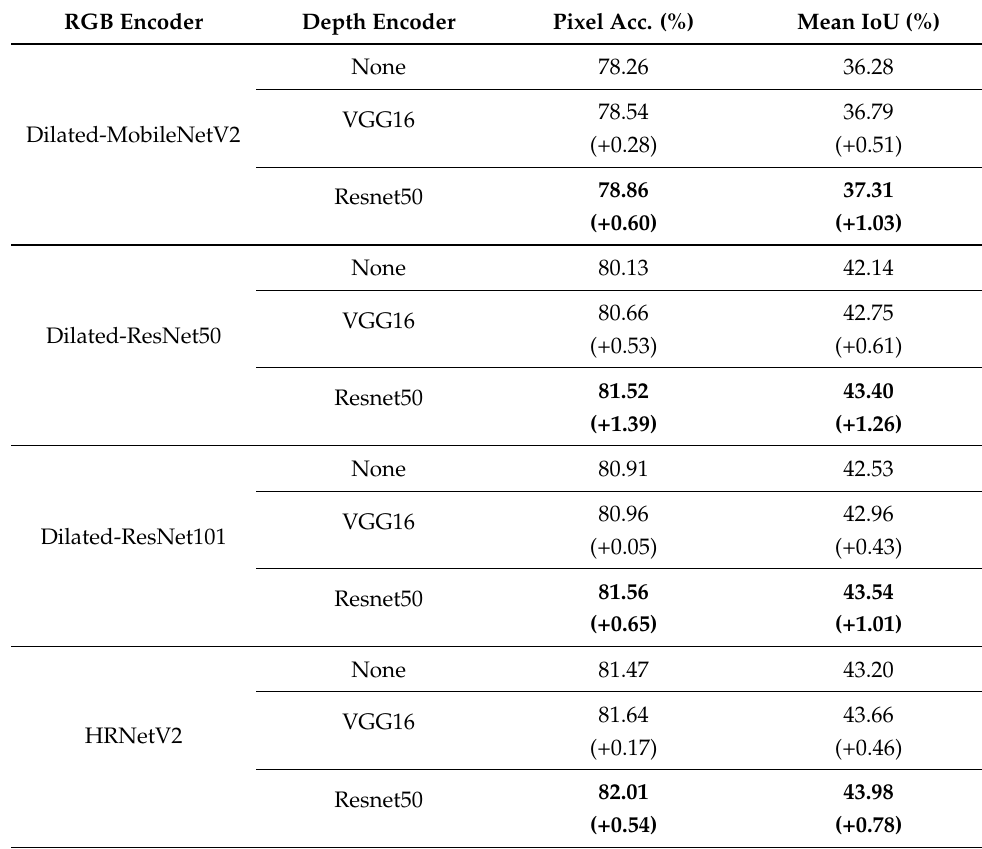
Table 1. Experimental results of our proposed models on ADE20k validation set. In the Depth encoder column, ‘None’ denotes no depth encoder in the model. RGB Encoder Depth Encoder Pixel Acc. (%) Mean IoU (%) None 78.26 36.28 Dilated-MobileNetV2